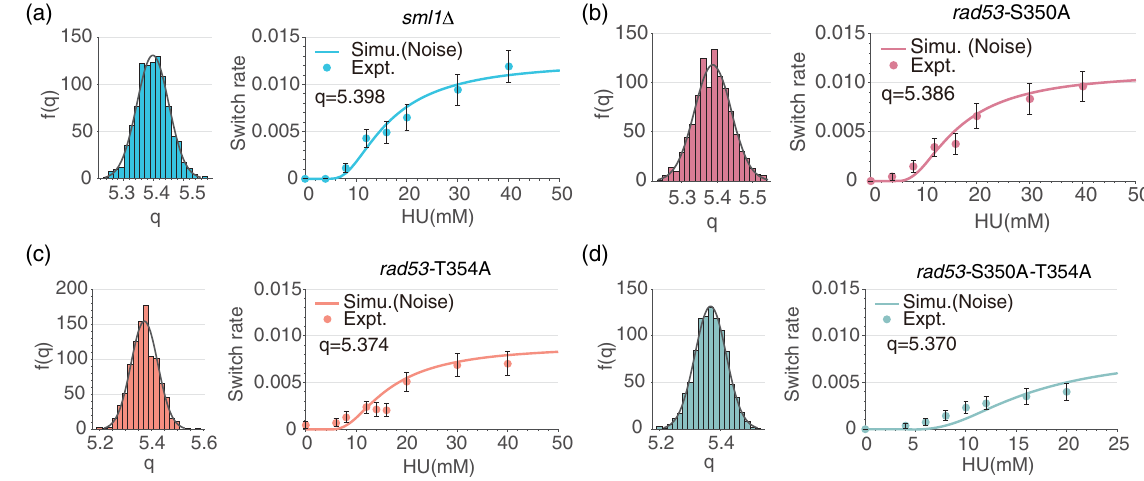
FIG. 14. Switch rate of sml 1 Δ (a), rad 53 -S 350 A (b), rad 53 -T 354 A (c), and rad 53 -S 350 A-T 354 A (d) strains after considering the heterogeneous growth effect. The left panel of each subfigure denotes the distribution of parameter q (parameter q is related to the growth heterogeneity effect) in our simulations, which obeys a Gaussian distribution. The right panel of each subfigure denotes the corresponding switch rate. The switch rate of the WT strain is similar to the sml 1 Δ strain, as shown in the Supplemental Material